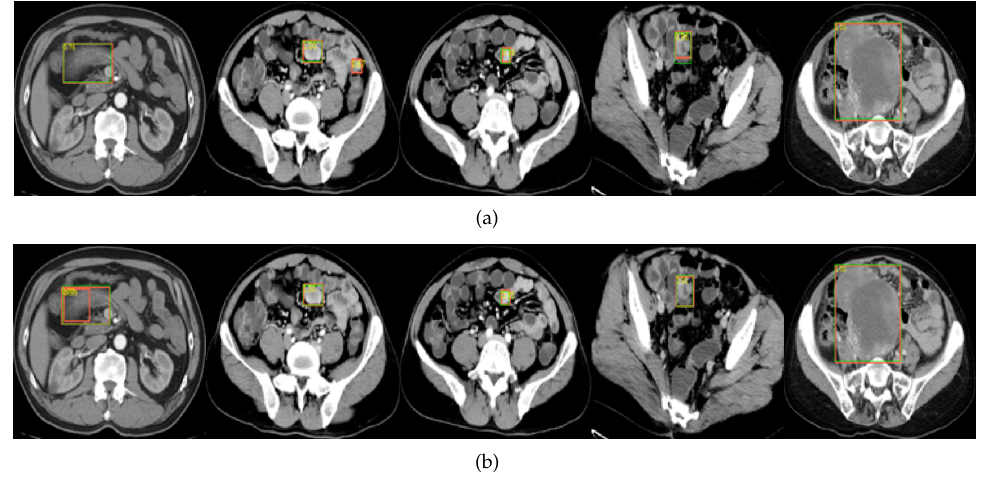
Figure 7. Visual comparison of ( a ) the fully supervised method and ( b ) semi-supervised method. The orange bounding box in the figure represents the predicted box, and the green bounding box represents the actual labeled